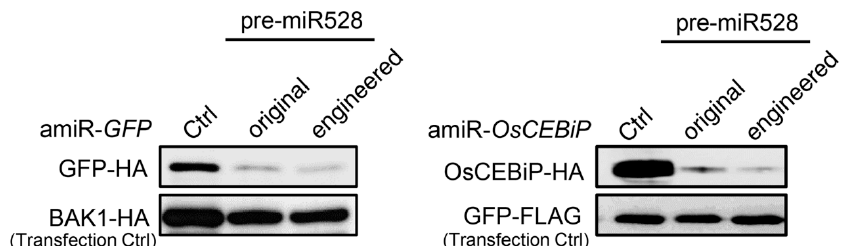
Figure 6. amiRNAs produced from the engineered pre-miR528 are functional in rice cells. Comparison of the performance of amiRNAs produced from the original or engineered pre-miR528 was conducted by the ETPamir assay. Three independent repeats with GFP-FLAG or BAK1-HA as an untargeted internal control produced similar results.